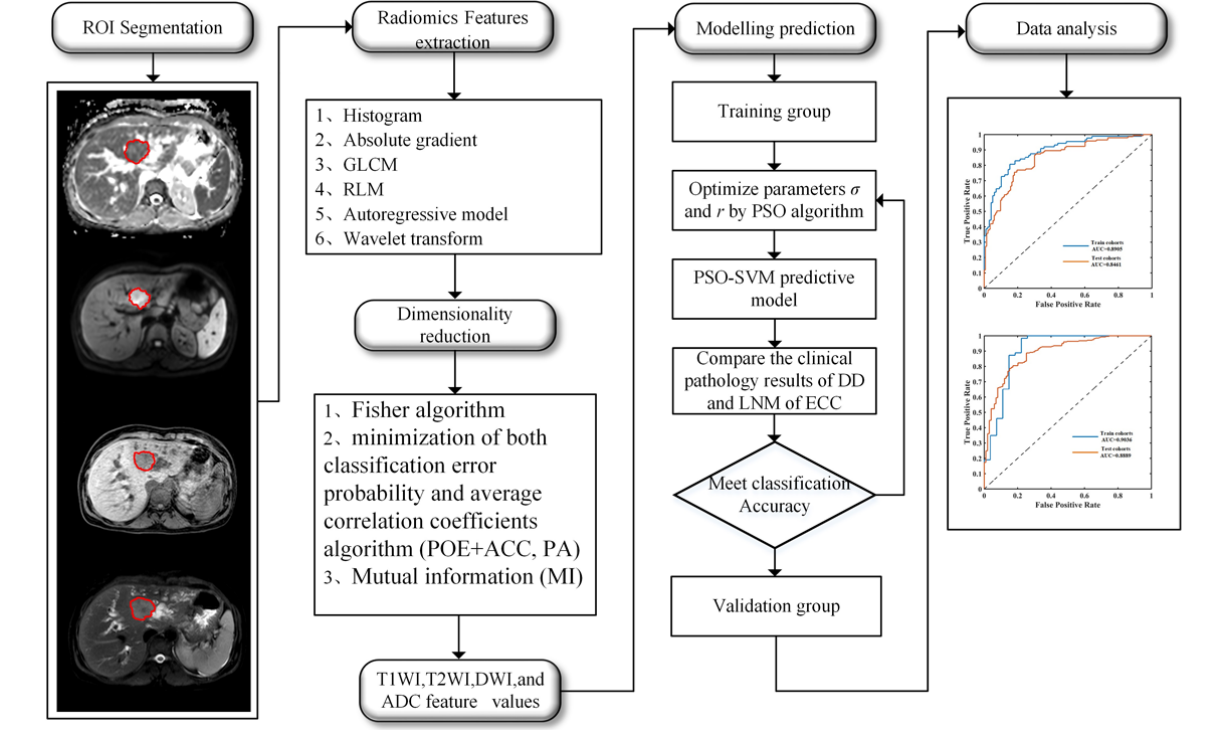
Figure 2. Research workflow of the paper. ADC: apparent diffusion coefficient; DD: differentiation degree; DWI: diffusion-weighted imaging; ECC: extrahepatic cholangiocarcinoma; GLCM: grey-level co-occurrence matrix; LMN: lymph node metastases; PSO-SVM: particle swarm optimization and support vector machine; RLM: grey-level run-length matrix; ROI: receiver operating characteristic curve; T1WI: T1-weighted imaging high spatial resolution isotropic volume exam; T2WI: fat-suppressed turbo spin-echo T2-weighted imaging spectral attenuated inversion